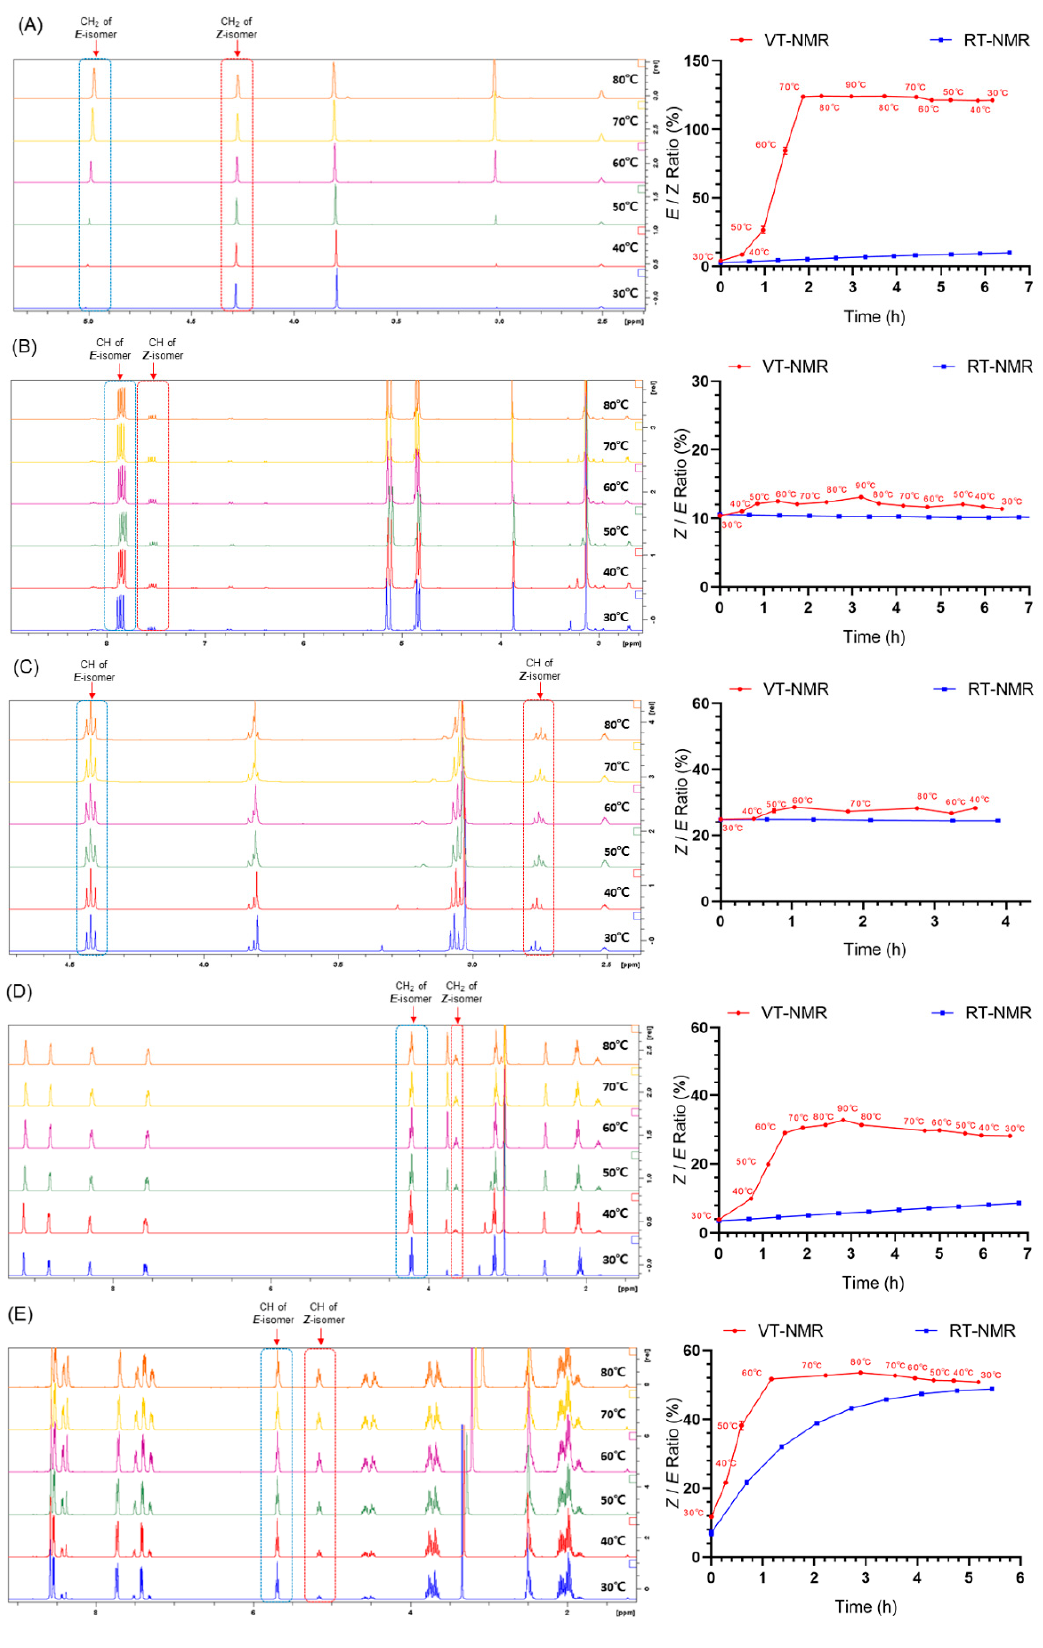
Figure 7. The Z/E ratios of asymmetrical N-nitrosamines 3 – 7 ( A – E , respectively) at different temperatures.